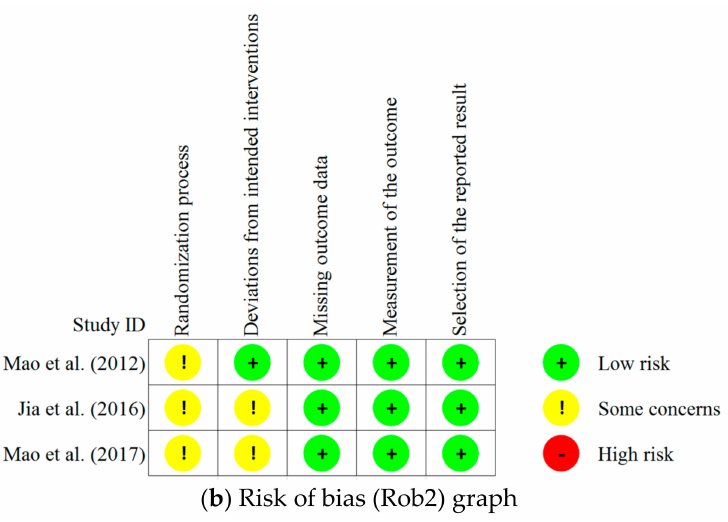
Figure 2. Risk of bias in included